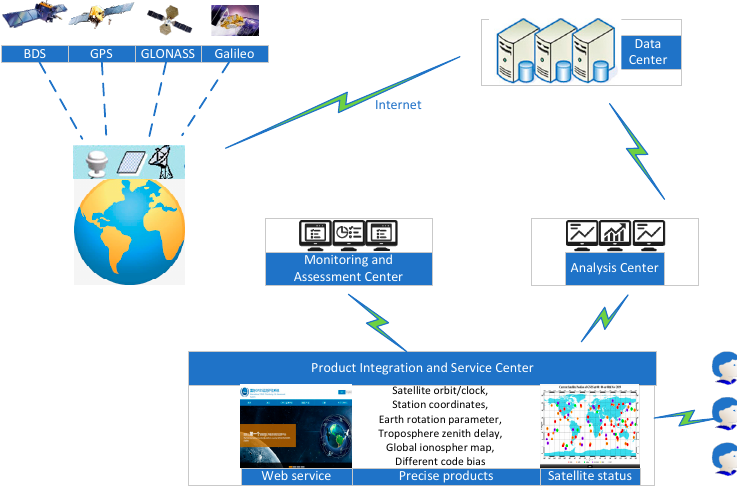
Figure 1. Architecture of